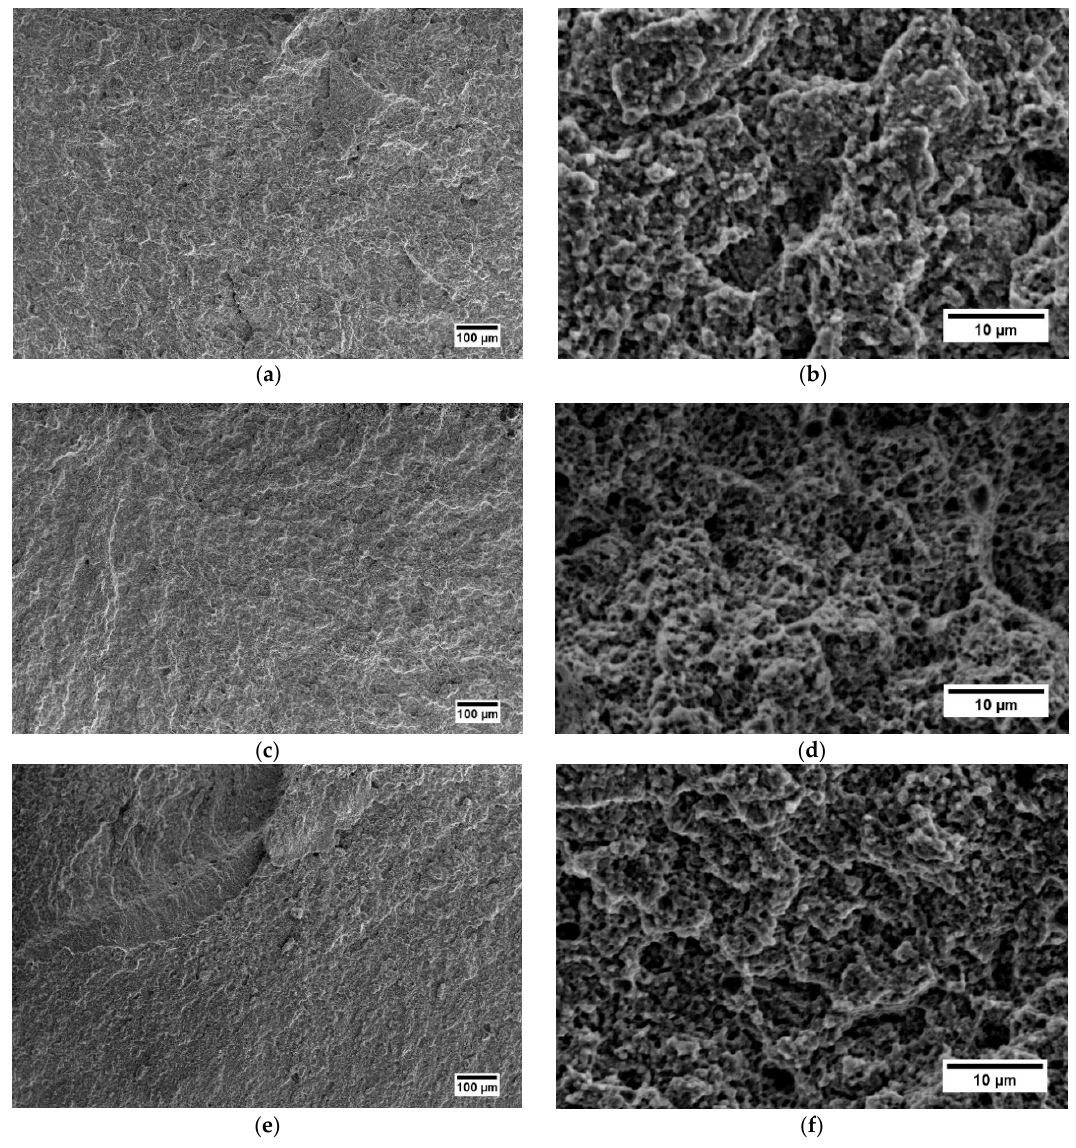
Figure 10. SEM micrographs of the fracture surfaces of: ( a ) and ( b ) as-HIPped, ( c ) and ( d ) HIPped and furnace cooling, ( e ) and ( f ) HIPped and water cooling specimens after tensile tests.